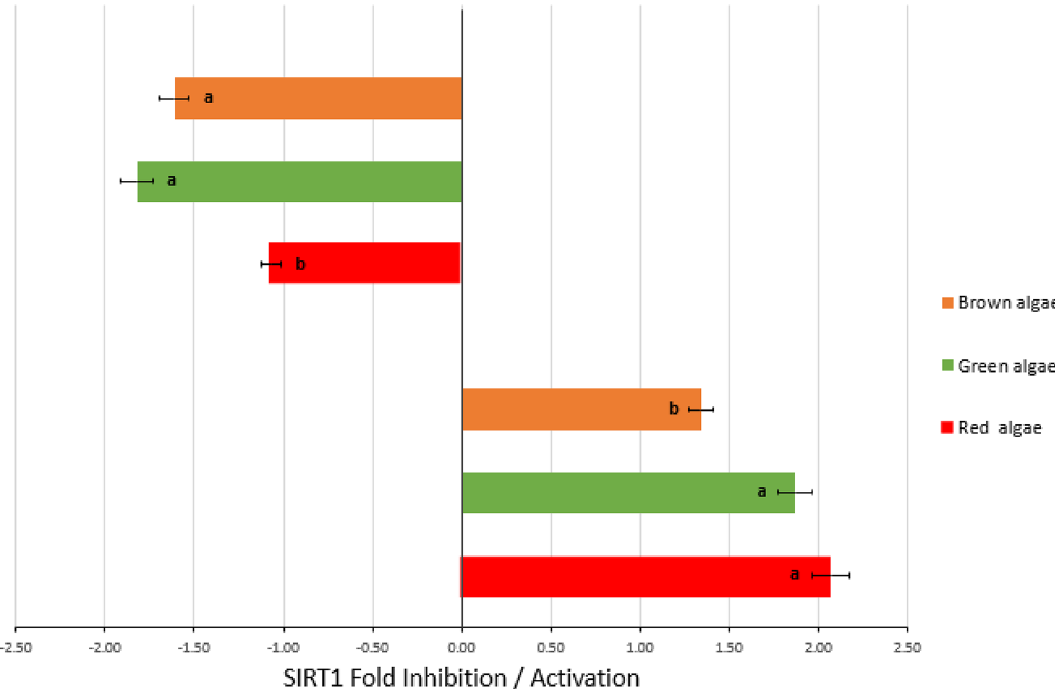
groups ( p < 0.05) with EPHs providing Fold inhibition. Different capital letters indicate significant differences between algae